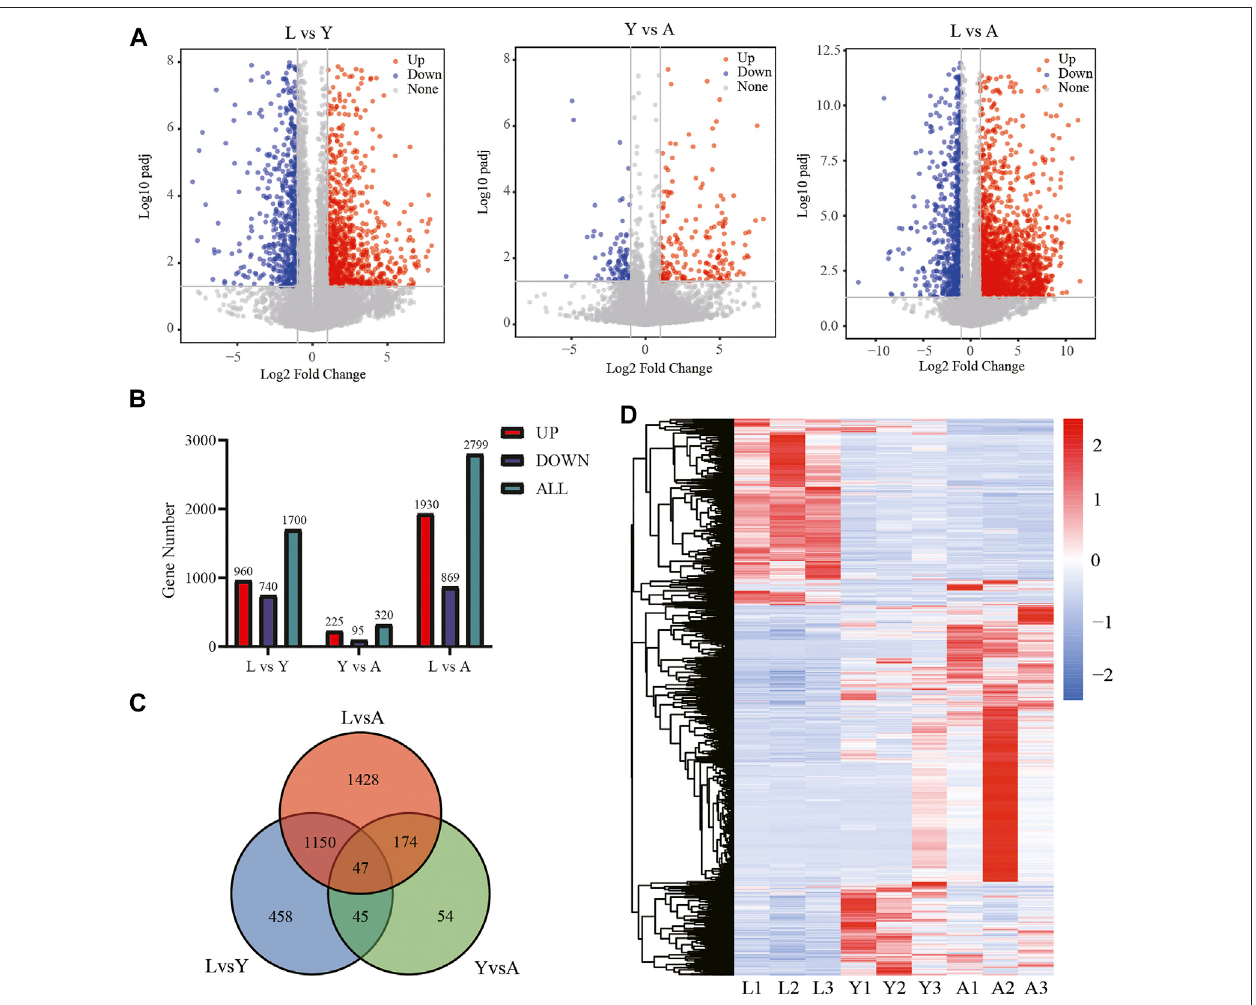
FIGURE 3 | Differential expression analyses of mRNAs. (A) Differential genetic volcano map Comparison of two different growth periods; (B) Differential gene statistics of different growth periods; (C) Venn plot of DEGs; (D) Differential gene cluster analysis.